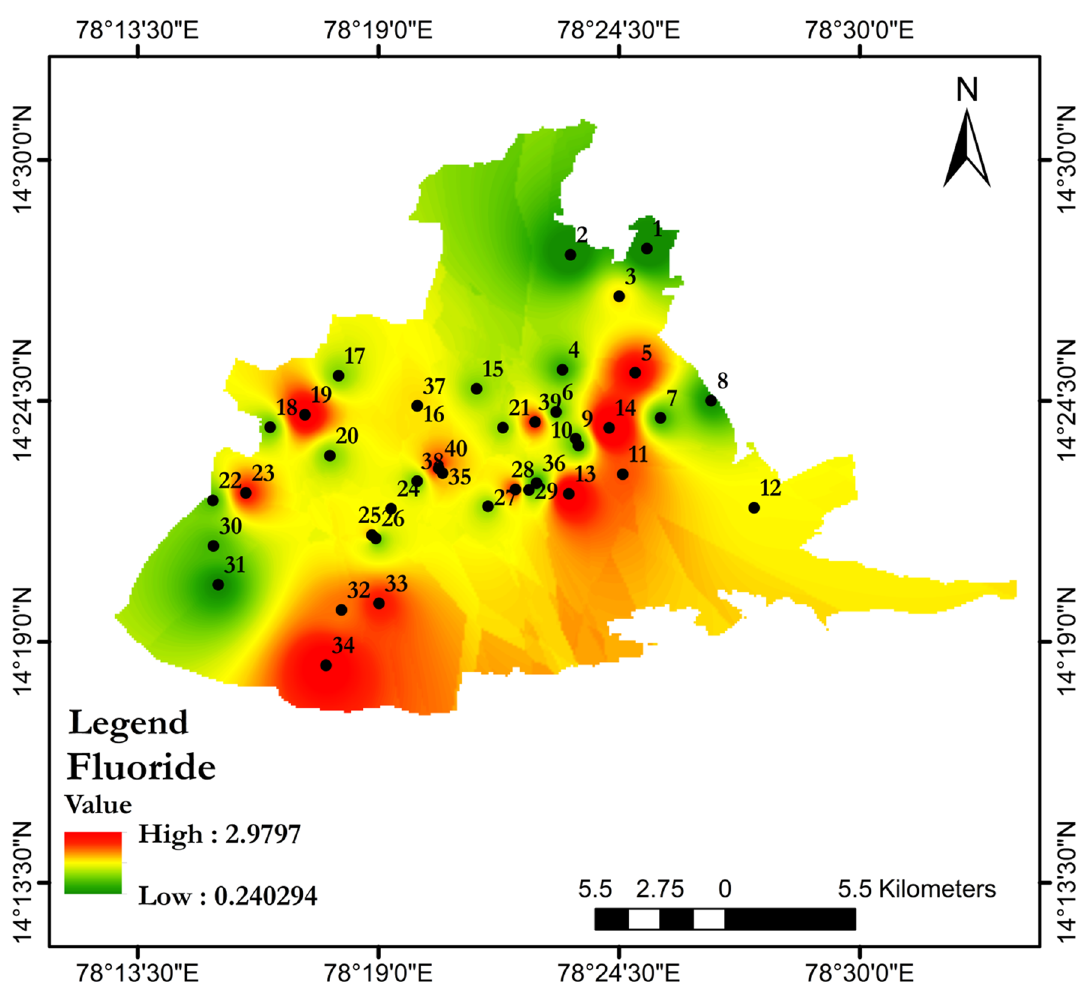
Fig. 6 Spatial distribution map of F − contamination